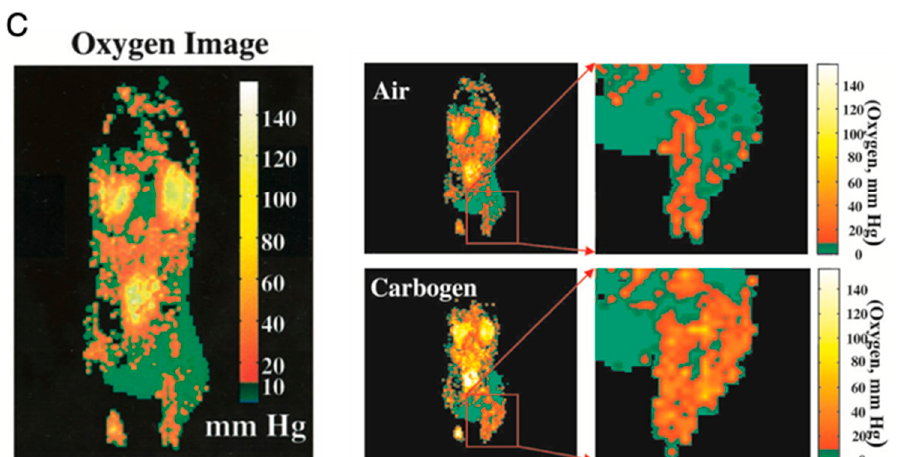
Figure 8. Imaging of mice pO 2 by OMRI/PEDRI. ( A ), Structure of trimethylaryl radical OX063. ( B ), Relative intensity of the different RF power-dependent images. ( C ), Oxygen image in mice body acquired by OMRI/PEDRI. Imaging of oxygenation in the C3H mice-bearing SCCVII tumors after Carbogen challenge.